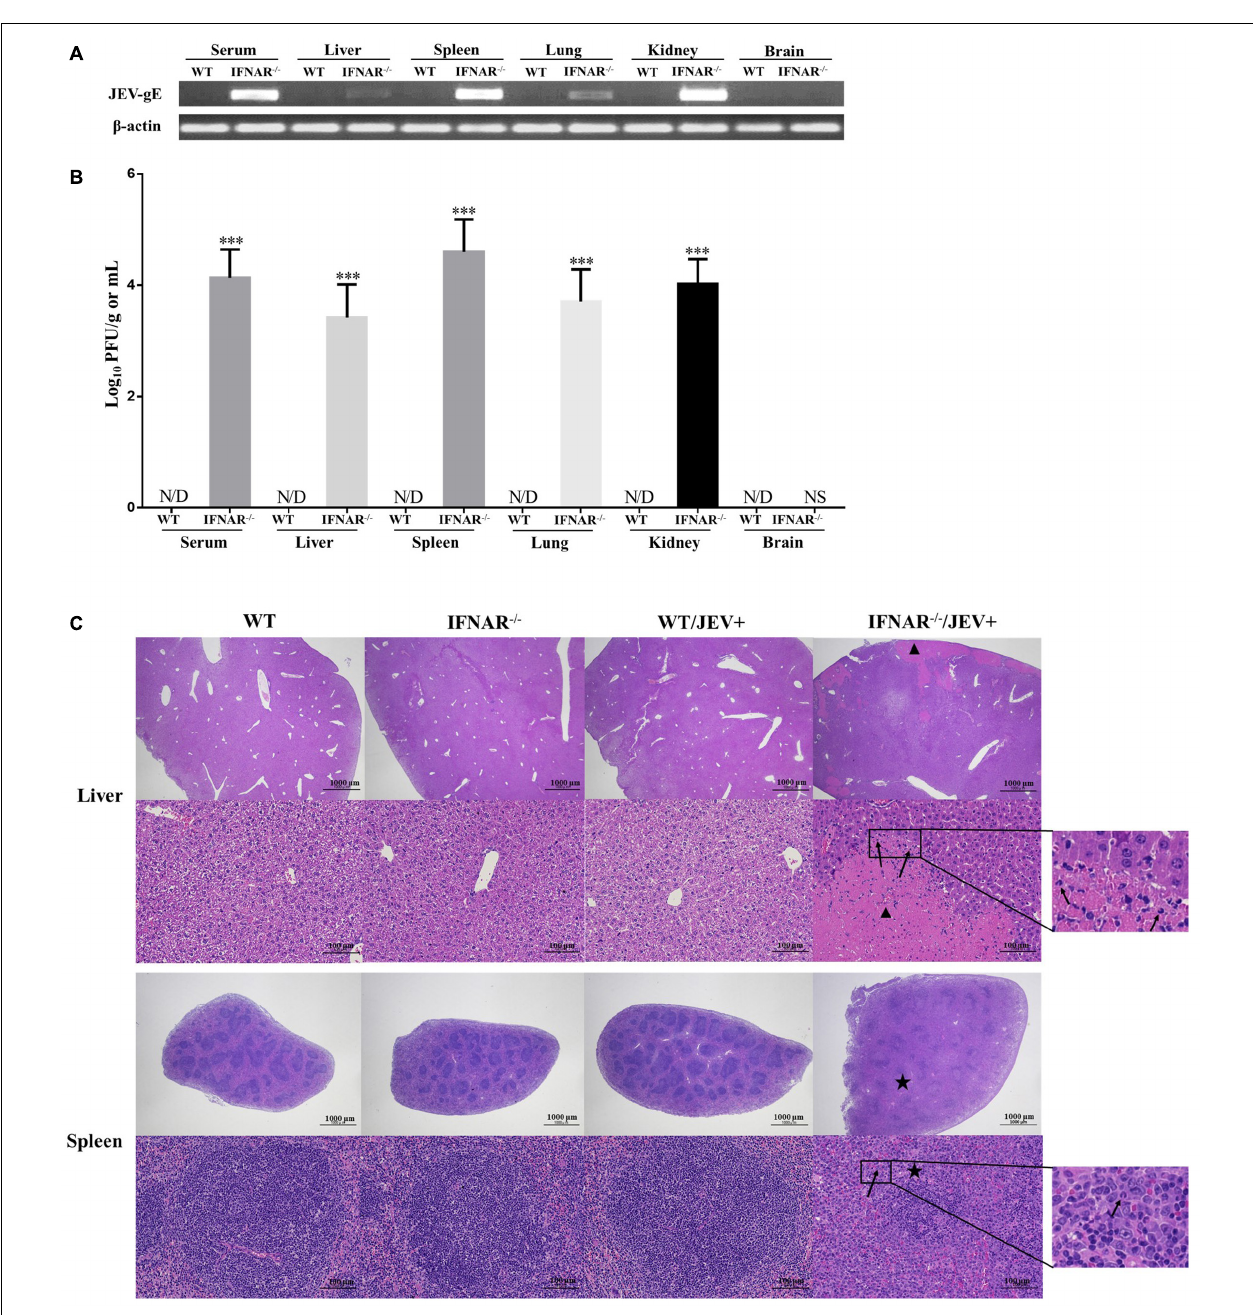
FIGURE 2 | Virus distribution and pathological changes of liver and spleen from SA14-14-2 strain infected- and uninfected-WT and IFNAR − / − mice. H&E; 20 × and 200 × . (A) WT and IFNAR − / − mice were intraperitoneally infected with JEV SA14-14-2 strain at 4 days post-infection (dpi), followed by PCR for the gE RNA levels in indicated organs and serum ( n = 4 per group). (B) Corresponding JEV SA14-14-2 strain load in indicated organs and serum was analyzed by using plaque-forming unit counts. Error bars represent the standard deviation of triplicate measurement ( n = 4 per group). (C) Representative pictures of tissues from the liver and spleen collected at 4 days post-infection (dpi) and stained with hematoxylin and eosin. Extensive necrosis (triangle) and infiltration of neutrophils (arrows) were detected in the liver, and severe lymphocytopenia (asterisk) and infiltration of neutrophils (arrows) were detected in the spleen. ∗∗∗ P < 0.001. NS, no significance. N/D, not